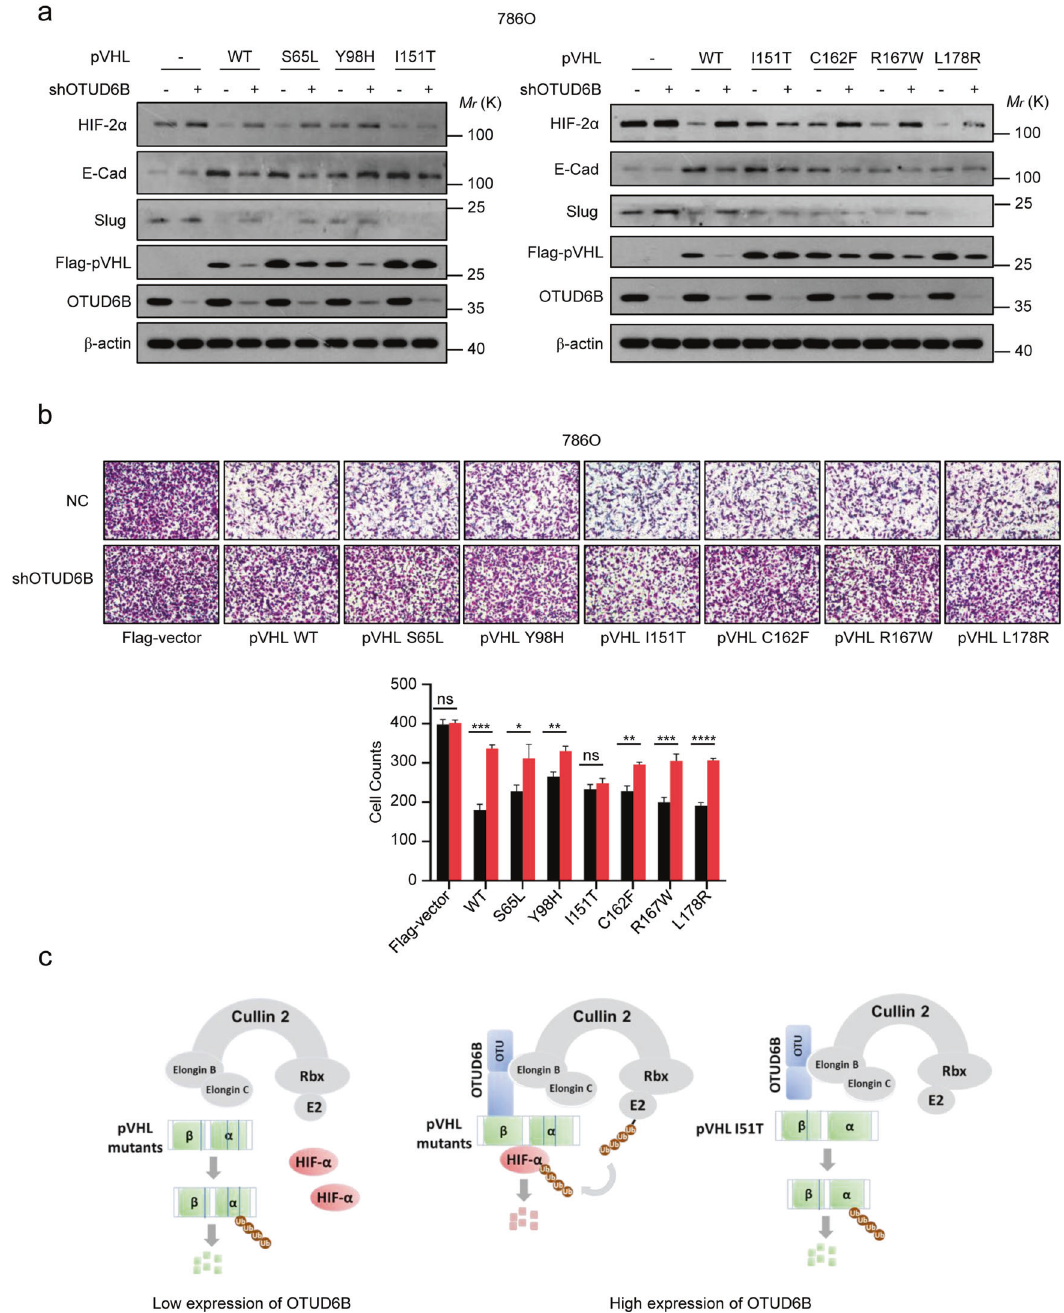
Fig. 7 OTUD6B knockdown in fl uences ectopic pVHL and the mutants induced cell migration inhibition. a pVHL or the mutant was transfected to 786O cells with OTUD6B stable knockdown. The cell lysates were immunoblotted with indicated antibodies. b Transwell assays were conducted in 786O cells. Cell counts were shown in histogram. Results are expressed as mean ± sd. Each error bar shows the standard deviations of three independent experimental values. * P < 0.05, ** P < 0.01, *** P < 0.001, **** P < 0.0001, Student ’ s t test. c The predicted work model how OTUD6B regulated the stability of pVHL missense